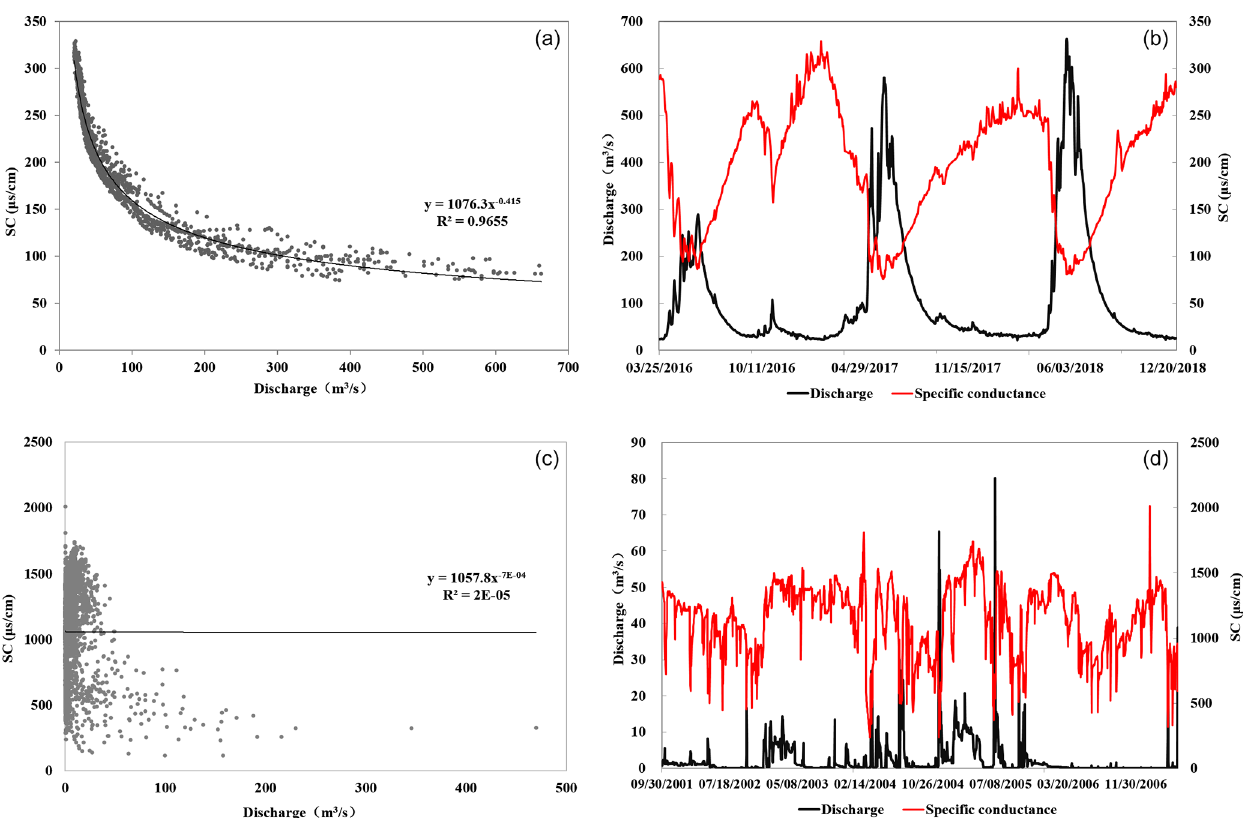
Figure 2. Inverse correlation between stream discharge and conductivity (a, c) and their temporal variation (b, d) . (a, b) Yellowstone River at Corwin Springs, MT, site no. 06191500. (c, d) North Canadian River below Lake Overholser near Oklahoma City, OK, site no. 07241000.